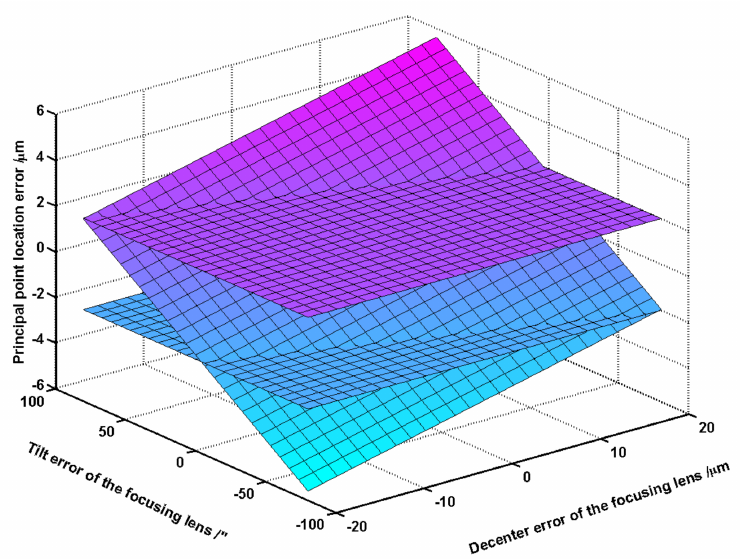
Figure 9. Principal point location error at different decenters and tilt